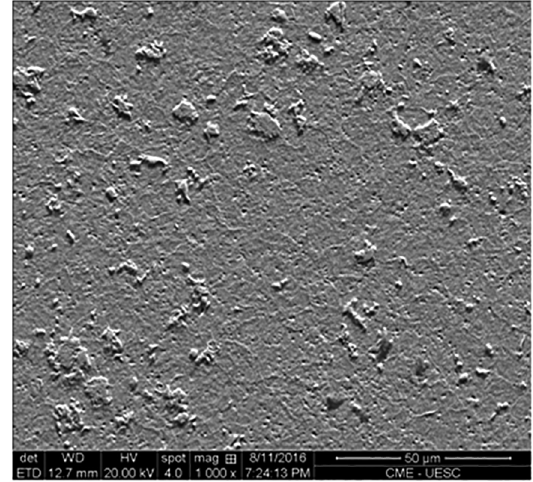
Figure 9. SEM micrograph of AISI 1020 carbon steel after 2 h of immersion in HCl 0.5 mol.L -1 in the presence of 1.77 g.L -1 of castor bark powder.